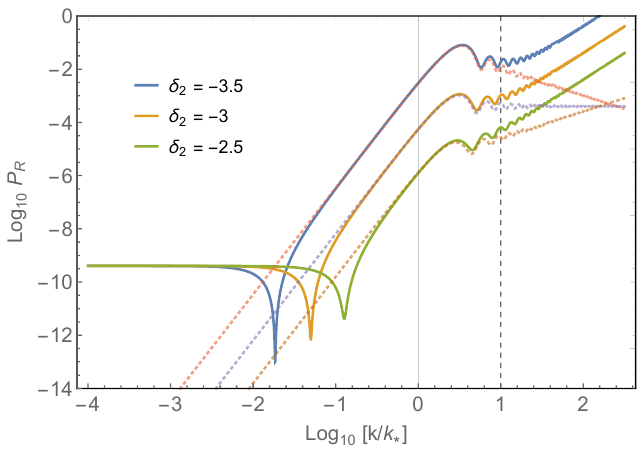
Figure 2 . The power spectrum P R from the slow-roll (Phase 1) to the negative constant rate (Phase 2) given by (2.38) with H k = 10 − 5 in Planck unit. The dotted lines are IR expansions given by (2.39). The dashed-vertical line is k = k ∗∗